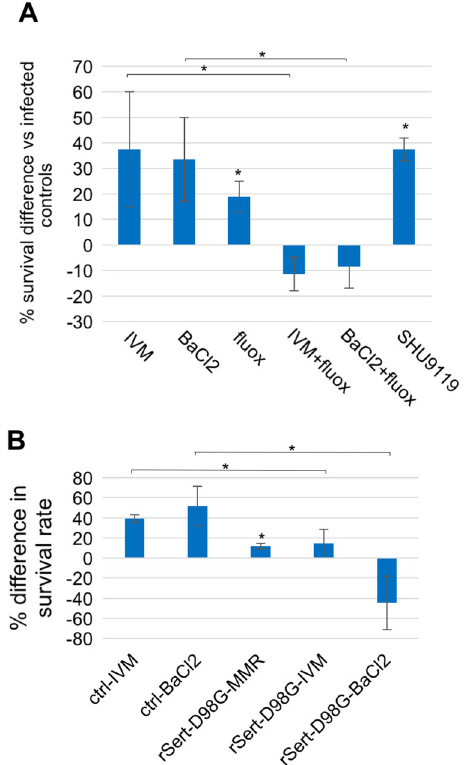
Fig. 2 Increased resistance to infection following chemical depolar- ization is mediated through a serotonergic signaling pathway. a Following infection, embryos were immediately incubated with the speci fi ed compounds. b For genetic inhibition of serotonergic signaling, a dominant-negative rat serotonin transporter mRNA encoding a mutant (rSert-D98G) was injected into one-cell embryos, which were grown to the gastrula stage, and infected with uropathogenic E. coli . Surviving embryos were counted 4 days after infection. Error bars represent the standard deviation from two biological replicates. *denotes p < 0.05. IVM ivermectin, fl